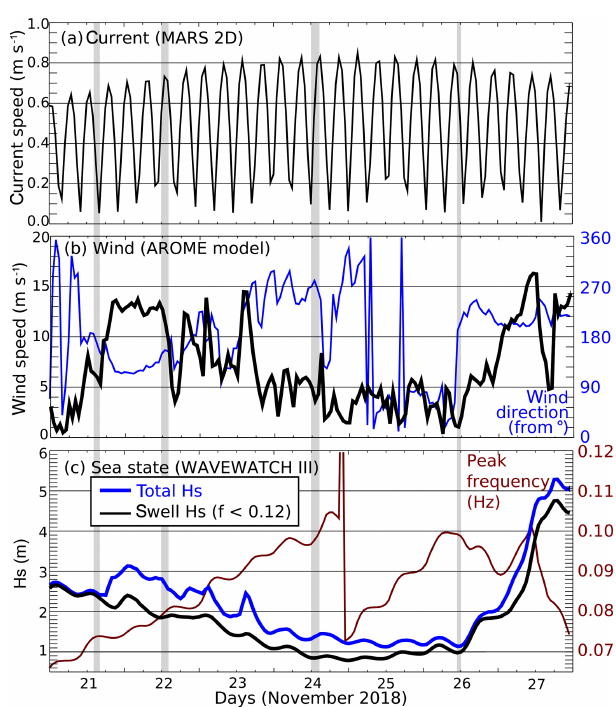
Figure 7. Time series at the location of the Trèfle buoy (5 ◦ 15 (cid:48) W, 48 ◦ 15 (cid:48) N) in the offshore zone of (a) ocean surface current speed from the MARS2D numerical model run at LOPS (Lazure and Du- mas, 2008). (b) Wind speed (black) and direction (blue) from the AROME regional operational model run by Météo-France. (c) Total (blue) and swell (black) significant wave height and wave peak fre- quency (red) from the WAVEWATCH III numerical wave model run at LOPS (Roland and Ardhuin, 2014). The four time periods shaded in gray correspond to the times of fixed-antenna KuROS measure- ments. The corresponding observed environmental parameters are detailed in Table